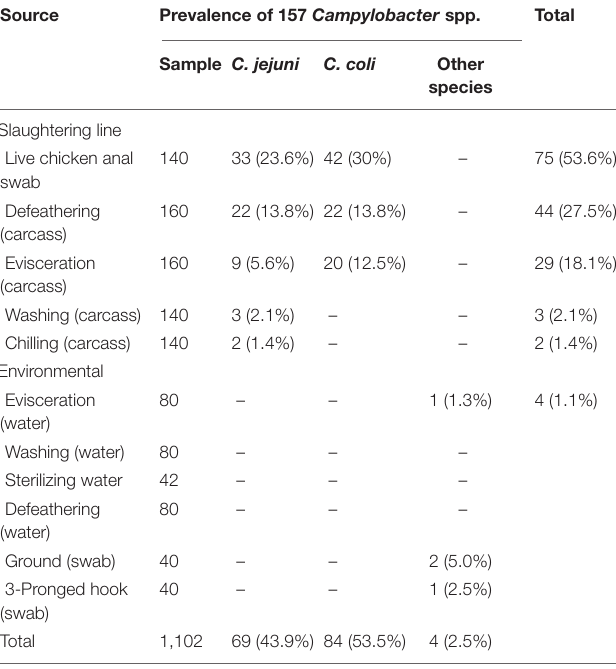
Table 1 . The specific sampling methods for each of the different links are based on previously described methods (Han et al., 2019). Each sample was labeled, transferred to the laboratory within 2 h, and processed